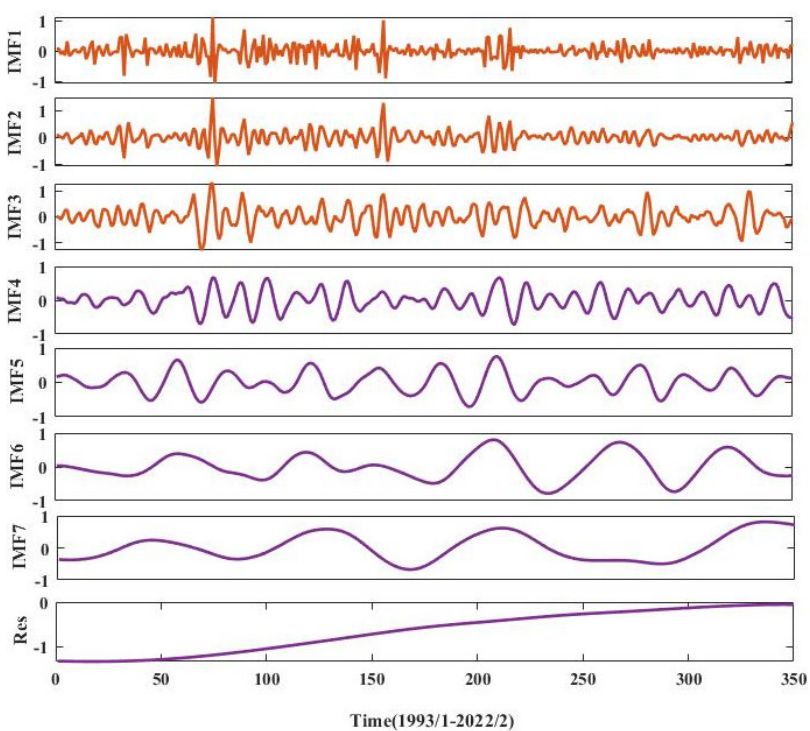
Figure 6. CEEMDAN primary modal decomposition results.